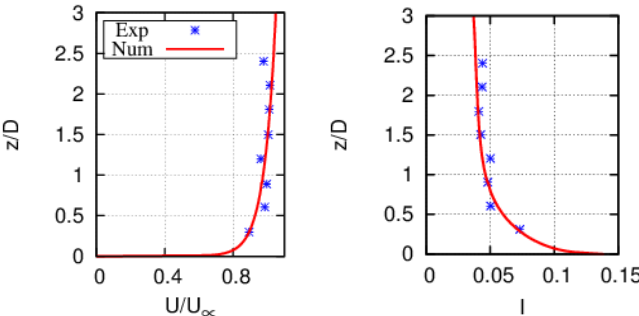
Figure 1. Vertical profiles of axial velocity ( left ) and turbulent intensity at the inlet ( right ). Comparison between numerical results (Num) and experimental (Exp) of Harrisson et al., 2010 [40]. Reproduced with permission from [38], Nguyen et al., Renewable Energy; published by Elsevier, 2016.